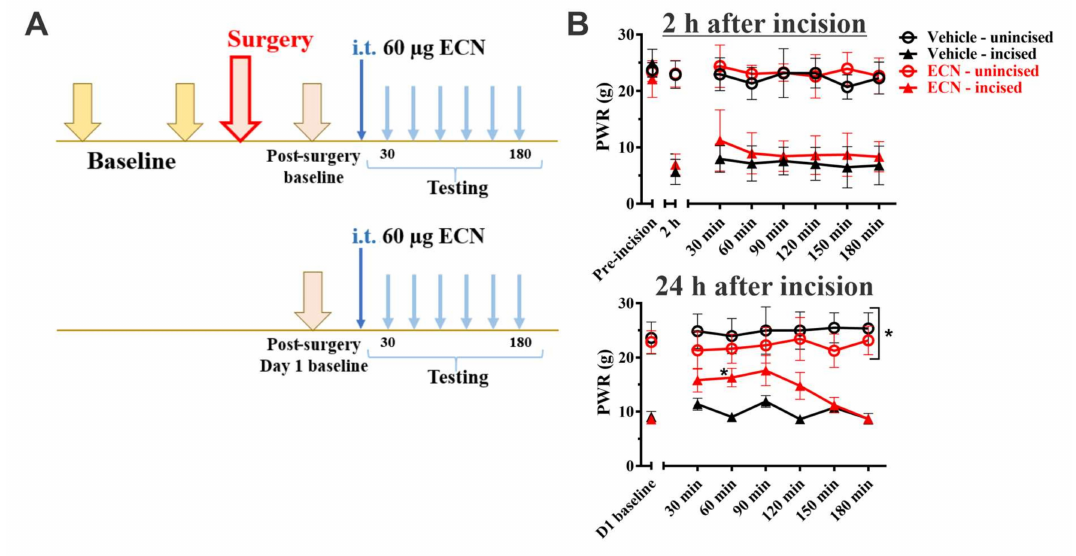
Figure 5. Repeated administration of ECN alleviates post-incisional mechanical hypersensitivity in rats. ( A ). A time-course showing baseline measurements to mechanical stimuli two days before incision, two hours and 24 h after incision. The paw withdrawal responses were measured every thirty minutes after i.t. injection of 60 µ g ECN. ( B ). A single i.t. injection of 60 µ g ECN two hours after incision does not a ff ect mechanical hypersensitivity (top; n = 6 for Vehicle and n = 9 for ECN groups). Second dose of ECN 24 h after incision significantly increases the mechanical sensitivity threshold in the incised paw (bottom; n = 7 for Vehicle and n = 8 for ECN groups). Each data point is represented as mean ± SD.